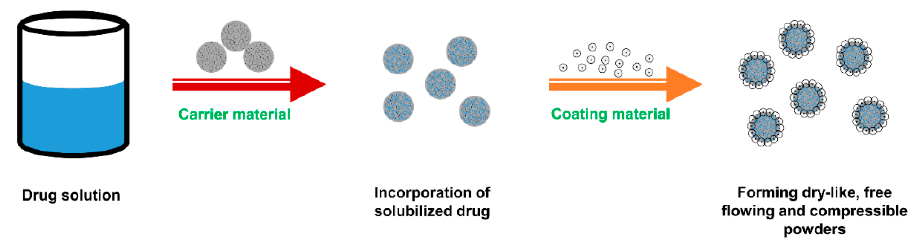
Figure 6. Formation process of dry-looking, freely flowing and compressible powders in the liquisolid system.